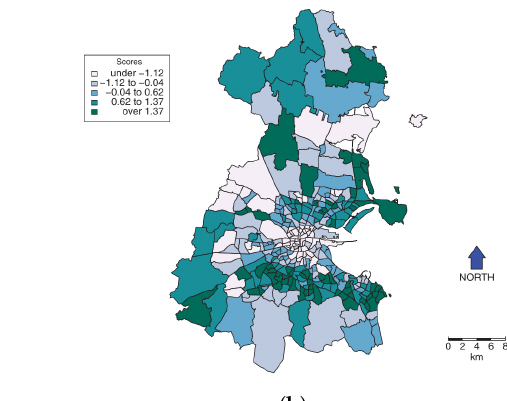
Figure 6. Ref. [112] (https://www.tandfonline.com/doi/full/10.1080/13658816.2011.554838 Geo- graphically weighted principal components analysis. Harris, P.; Brunsdon, C.; Charlton, M. Interna- tional Journal of Geographical Information Science 2011 , 25 , 1717–1736, Taylor and Francis. Reprinted by permission of the publisher). ( a ) Summary of global PCA for eight variables representing social struc- ture in Greater Dublin (the first three components express more than 70% of variations). ( b ) Spatial distribution of first component scores from global